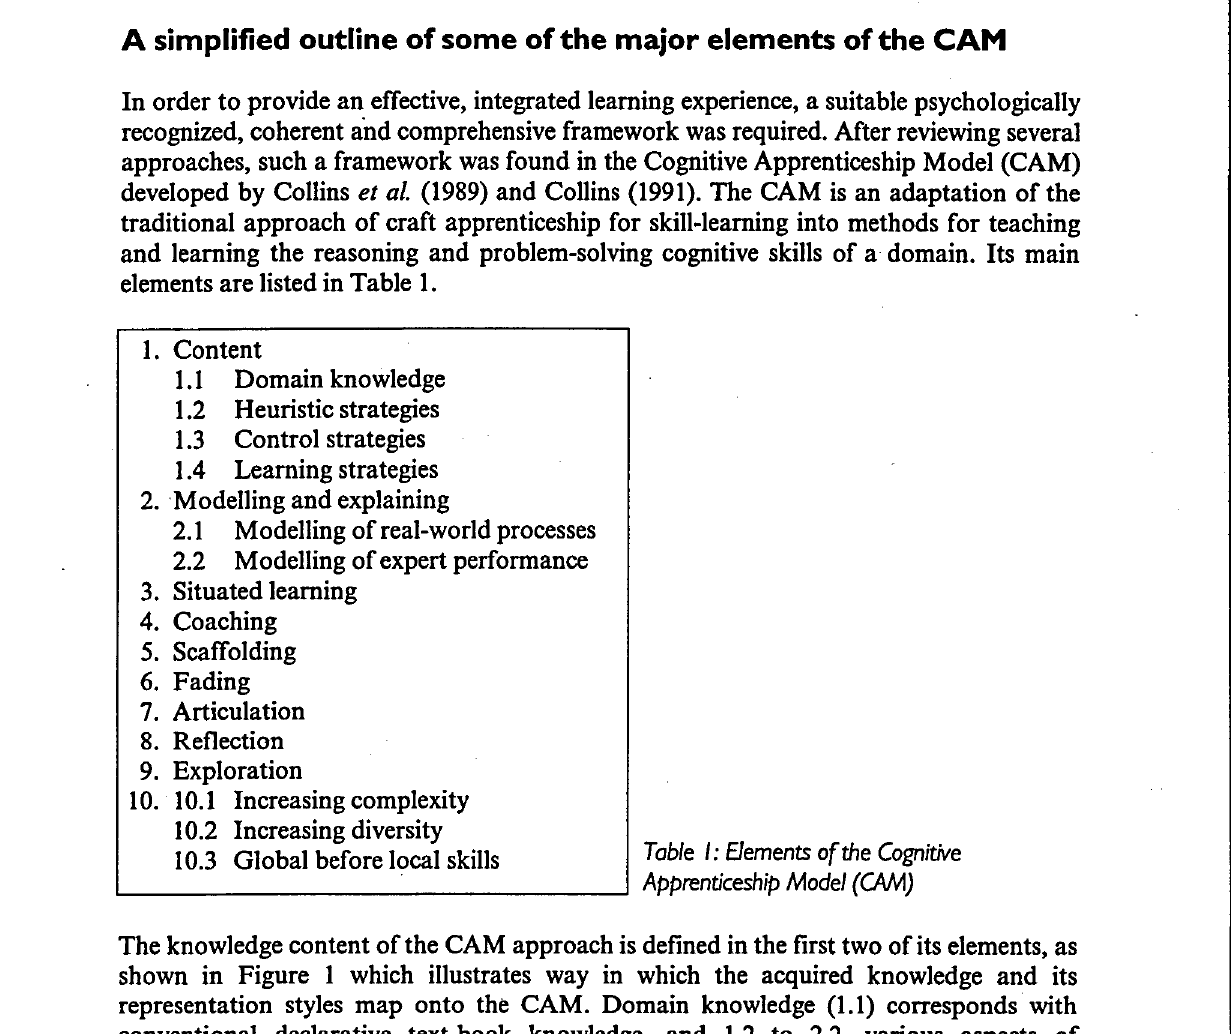
Table I: Elements of the Cognitive Apprenticeship Model